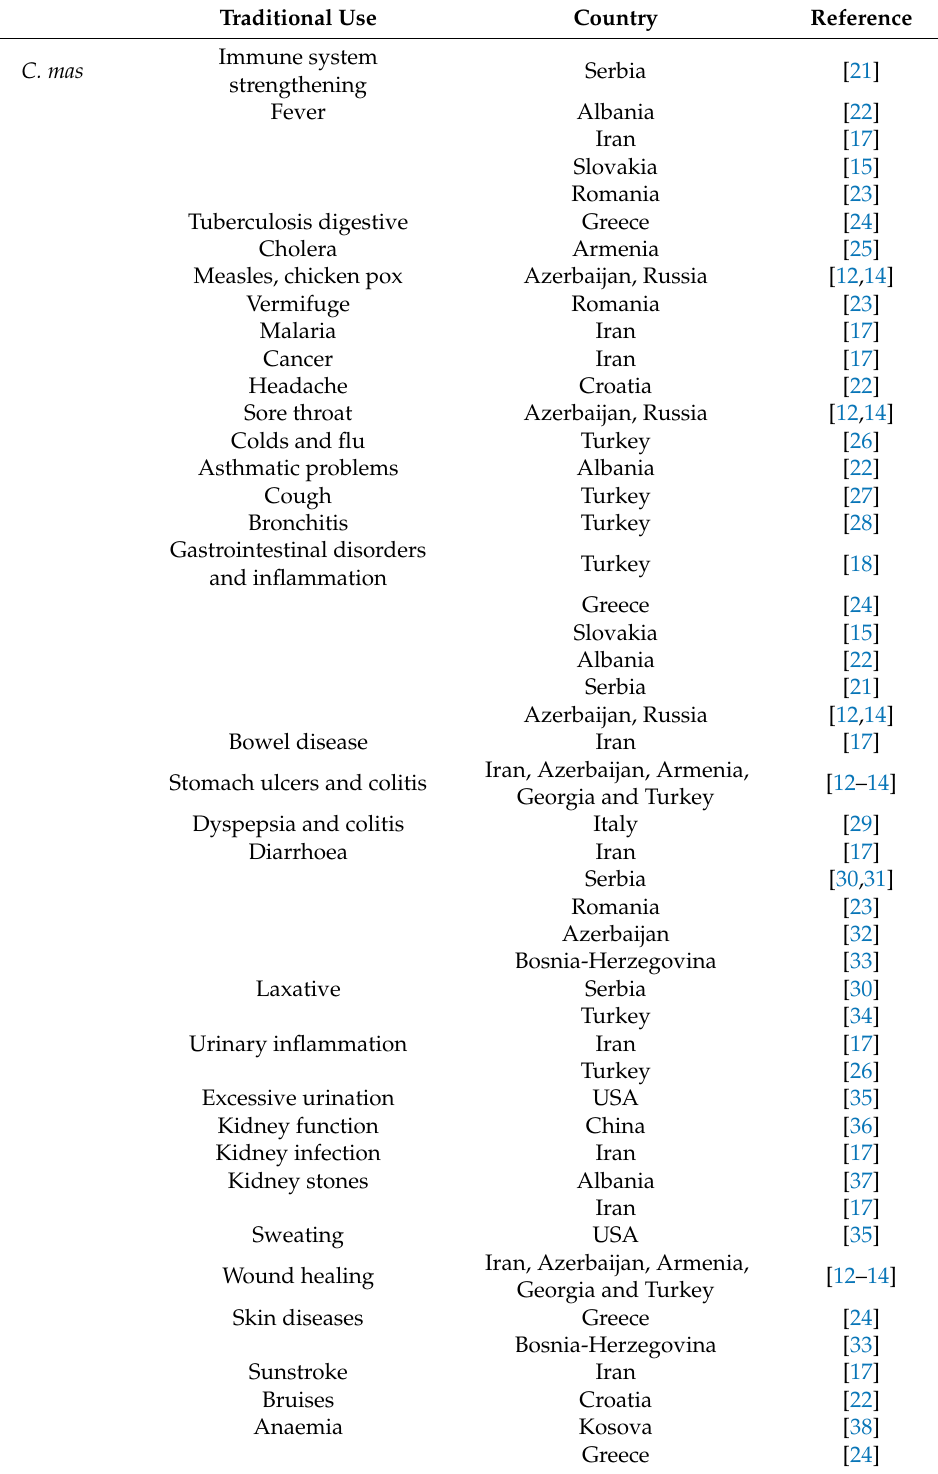
Table 1. Traditional uses of Cornus fruits